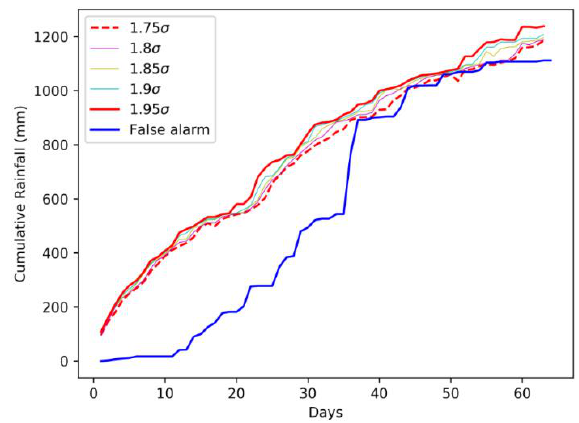
Figure 6. Visualization of calibration algorithm. The threshold value was raised till the cumulative rainfall curve of the event (F) is not crossing the threshold curve (standard threshold of 1.75 is optimized to 1.95).